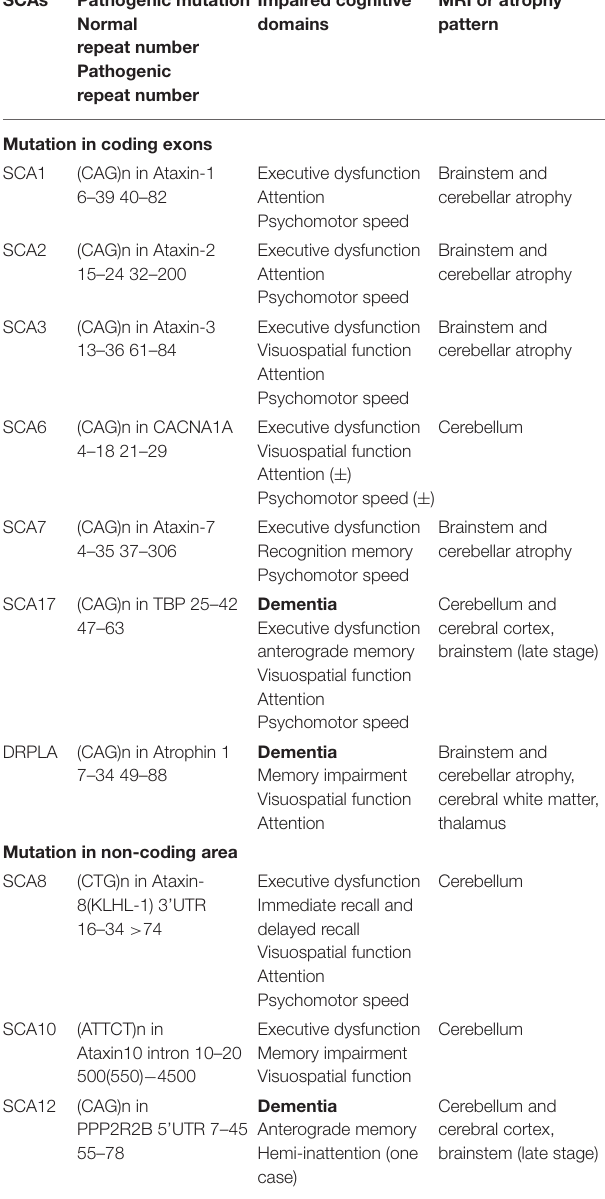
TABLE 1 | The pathogenic mutation, impaired cognitive domains, and atrophy patterns of SCAs with cognitive dysfunction.